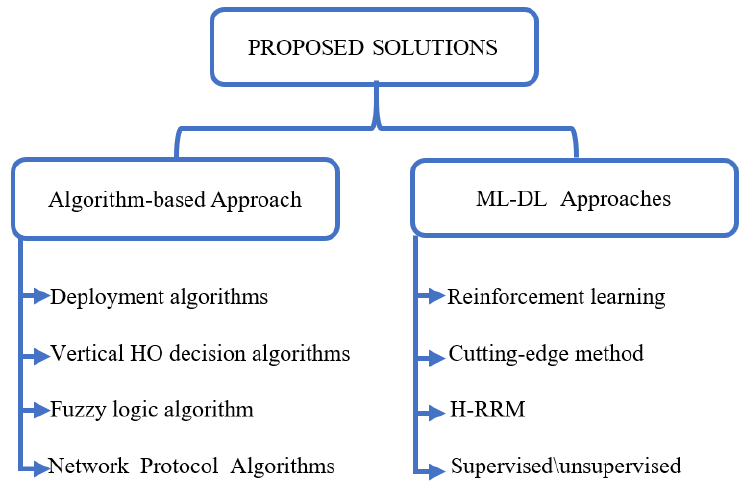
Figure 9. To provide a complete picture, the main classification of proposed solutions can be illus- trated as two main